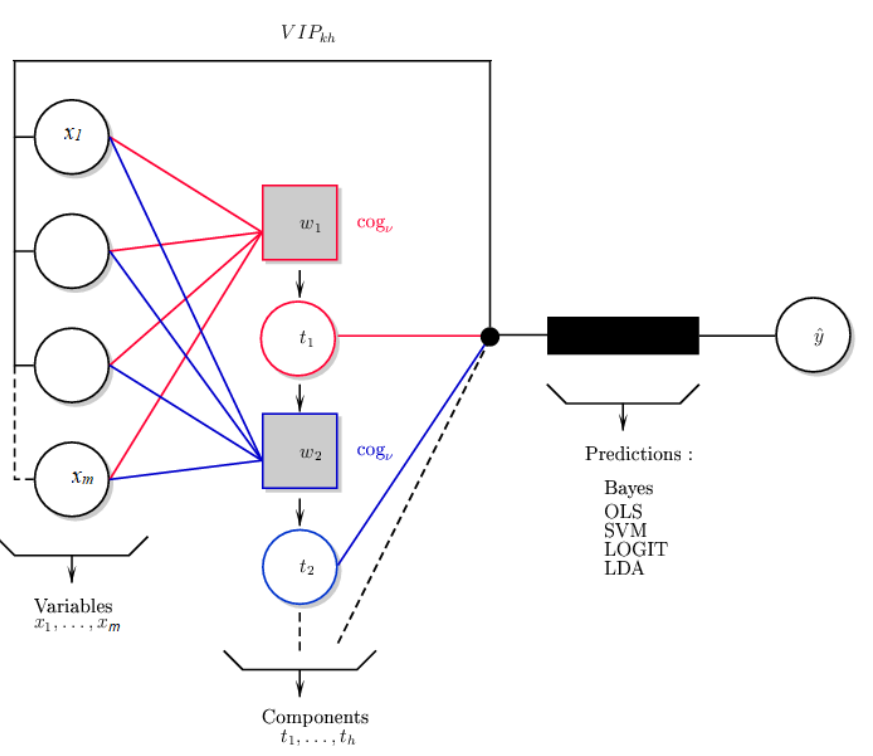
Figure 4. Generalized Gini-PLS